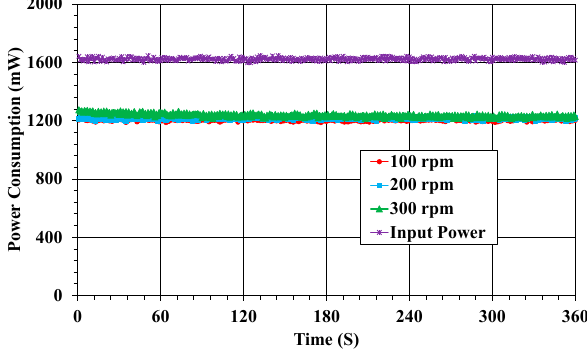
Figure 5. Power monitoring results in the WSS.